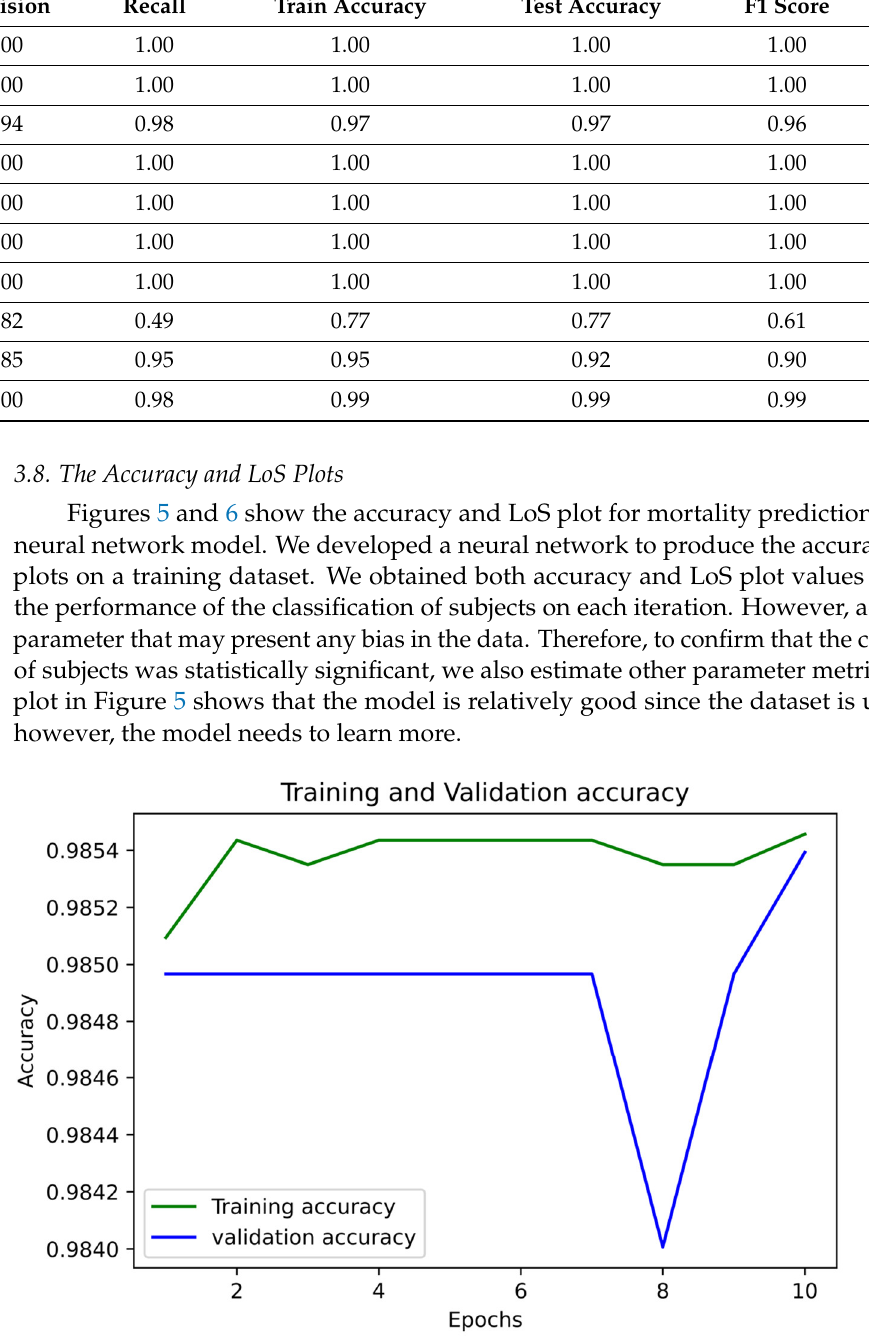
Figure 6. LoS Plot for Mortality Prediction. 3.9. The AUC and Precision-Recall Curves The Figures 7–12 represent the AUC and Precision-recall curves for the different models used for prediction of LoS and mortality.